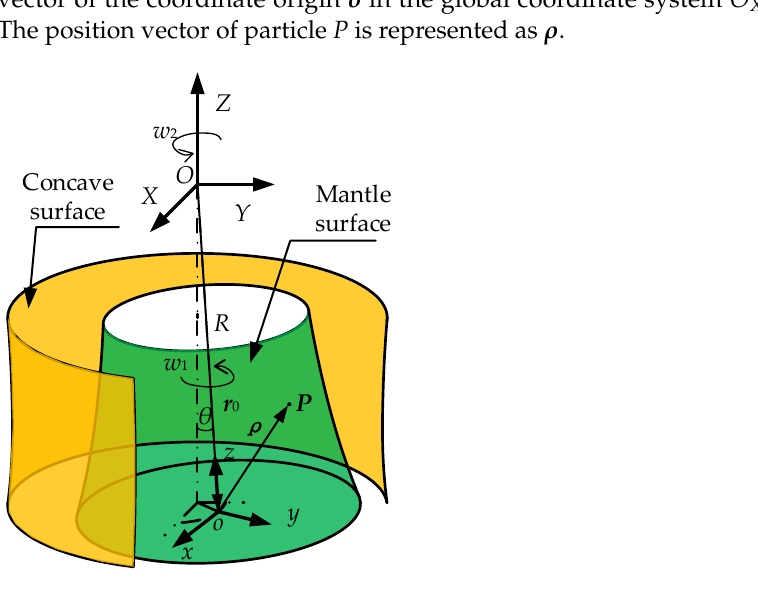
Figure 3. The location of the moving coordinate system and the global coordinate system. Based on the coordinate system transformation theory [17], the coordinate system transformation matrix which converts the coordinates and vectors from the moving coordi- nate system to the global coordinate system is established as shown in Equations (1) and